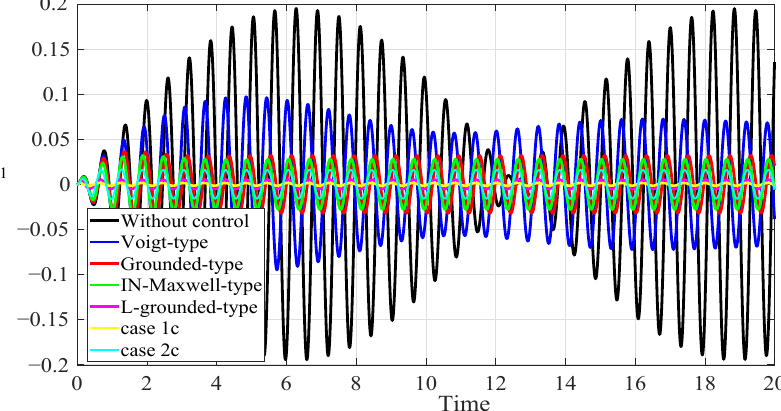
Figure 13. Normalized displacement response of the primary system under a harmonic force excita- tion, when ω = 10.5